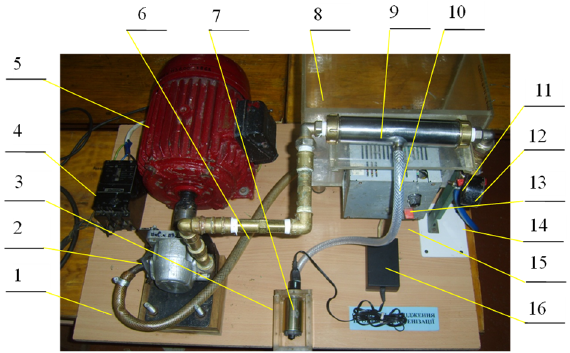
Figure 3. Laboratory installation of a jet-slot milk homogenizer: 1—a flexible pipeline for supplying skim milk; 2—gear pump; 3—container with cream; 4—packet switch; 5—electric three-phase motor; 6—pipeline; 7—cream feed pump; 8—container with skim milk; 9—homogenizing node; 10—a flexi- ble hose with a clamp for supplying cream; 11—throttle valve; 12—manometer;